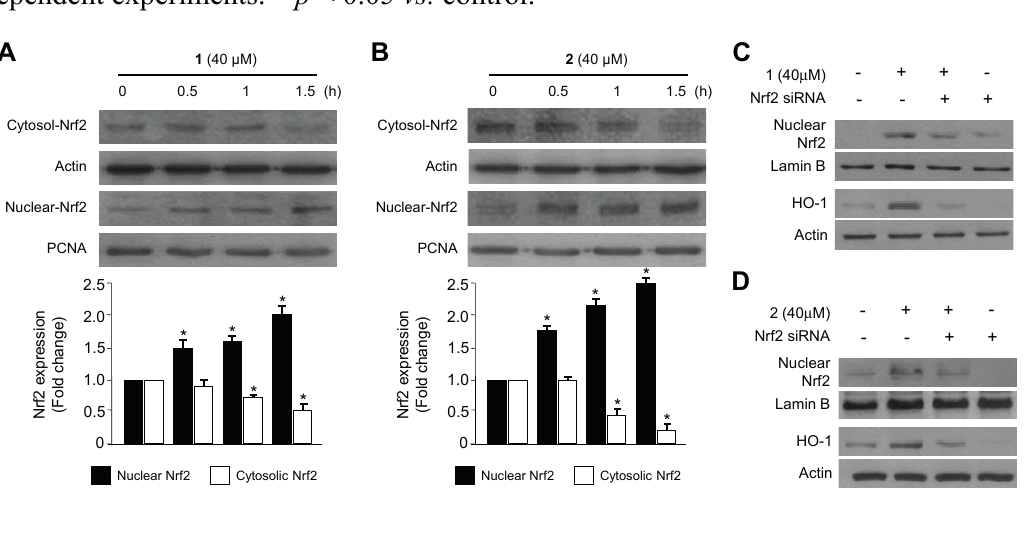
Figure 3. Effects of compounds 1 and 2 on the nuclear translocation of Nrf2 ( A , B ) and Nrf2-mediated HO-1 expression ( C , D ) in RAW264.7 macrophages. RAW264.7 macrophages were treated with 1 and 2 (40 μ M) for 0.5, 1, and 1.5 h ( A , B ). RAW264.7 macrophages were transiently transfected with Nrf2 siRNA and then treated with 1 and 2 (40 μ M) for 12 h (HO-1) or 1.5 h (Nuclear Nrf2) ( C , D ). Data are represented as the mean ± S.D. of three independent experiments. * p < 0.05 vs.